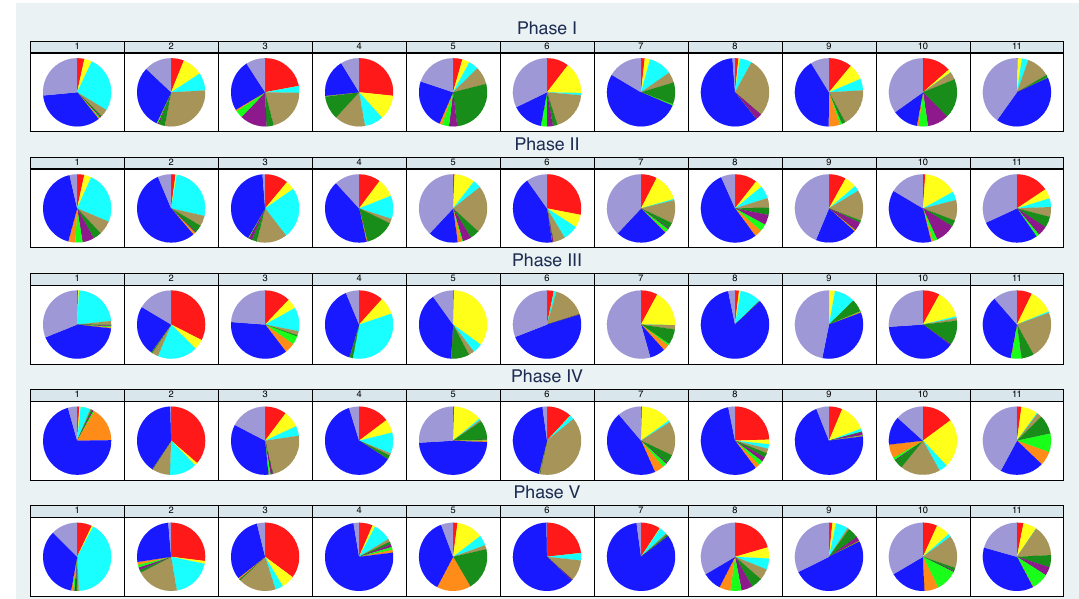
Figure 2. Fractions of the bacterial groups on the total concentration per participant (column) and phase (row) based on mean values per phase.